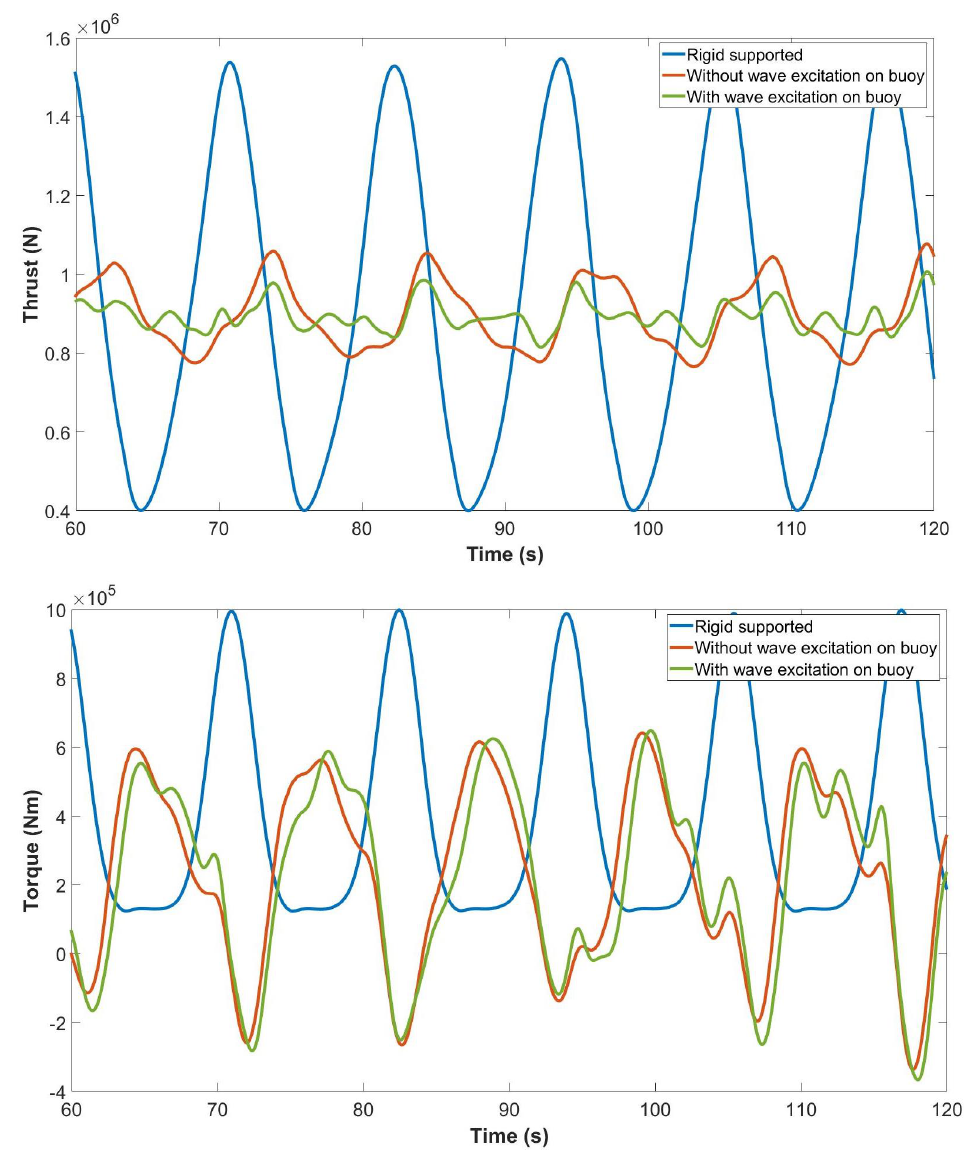
Figure 10. Thrust and torque in harsh